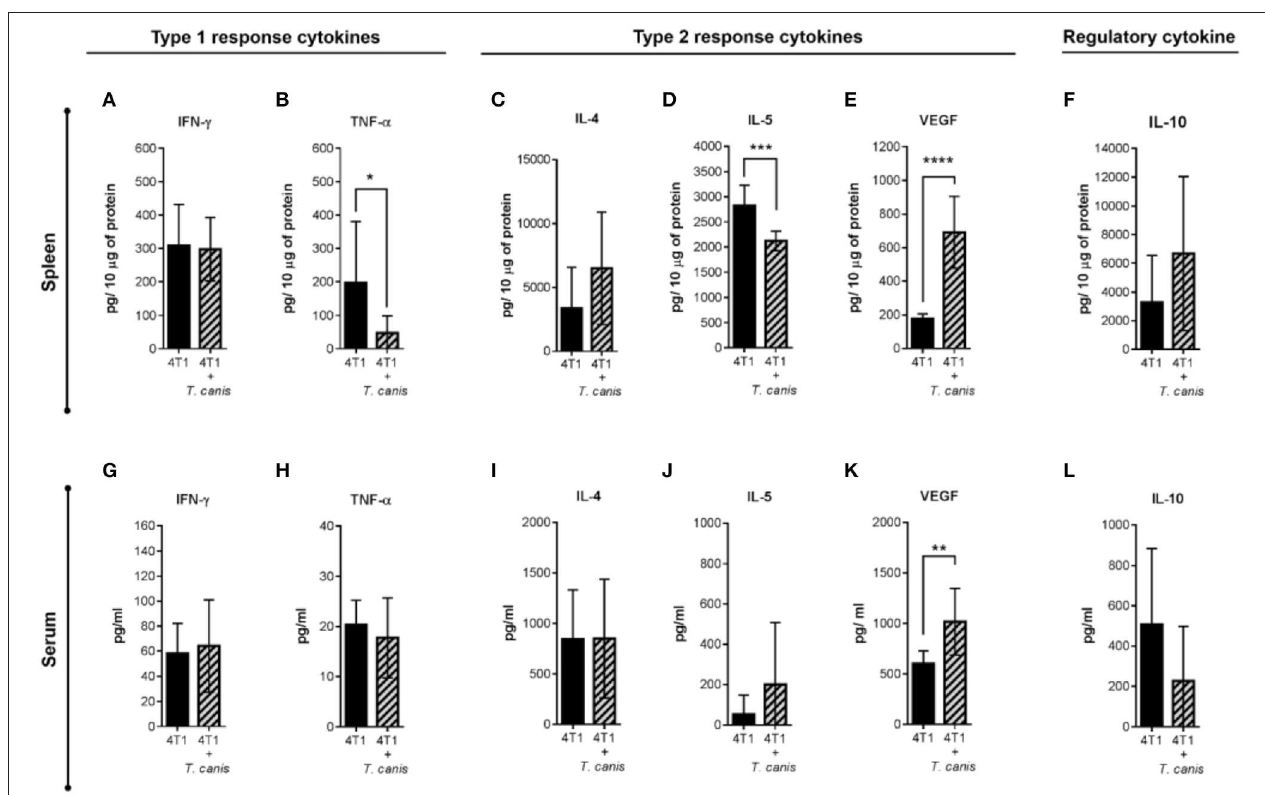
FIGURE 6 | Analysis of systemic soluble factor expression in spleen and serum. Determination by sandwich ELISA of the splenic type 1 response cytokines. (A) IFN- γ . (B) TNF- α ; the type 2 cytokines: (C) IL-4, (D) IL-5, (E) VEGF; and the regulatory cytokine. (F) IL-10. Analysis of soluble factors in serum. (G) IFN- γ . (H) TNF- α . (I) IL-4. (J) IL-5. (K) VEGF. (L) IL-10. Graphs indicate data from splenic proteins and sera obtained from two independent experiments (4T1, n = 10; 4T1 + T. canis , n = 10). Bars represent the mean ± SD of cytokine levels (pg/10 µ g of splenic proteins or pg/ml of sera). Statistical significance was calculated using a t -test (* p ≤ 0.05; ** p ≤ 0.01; *** p ≤ 0.001; **** p <